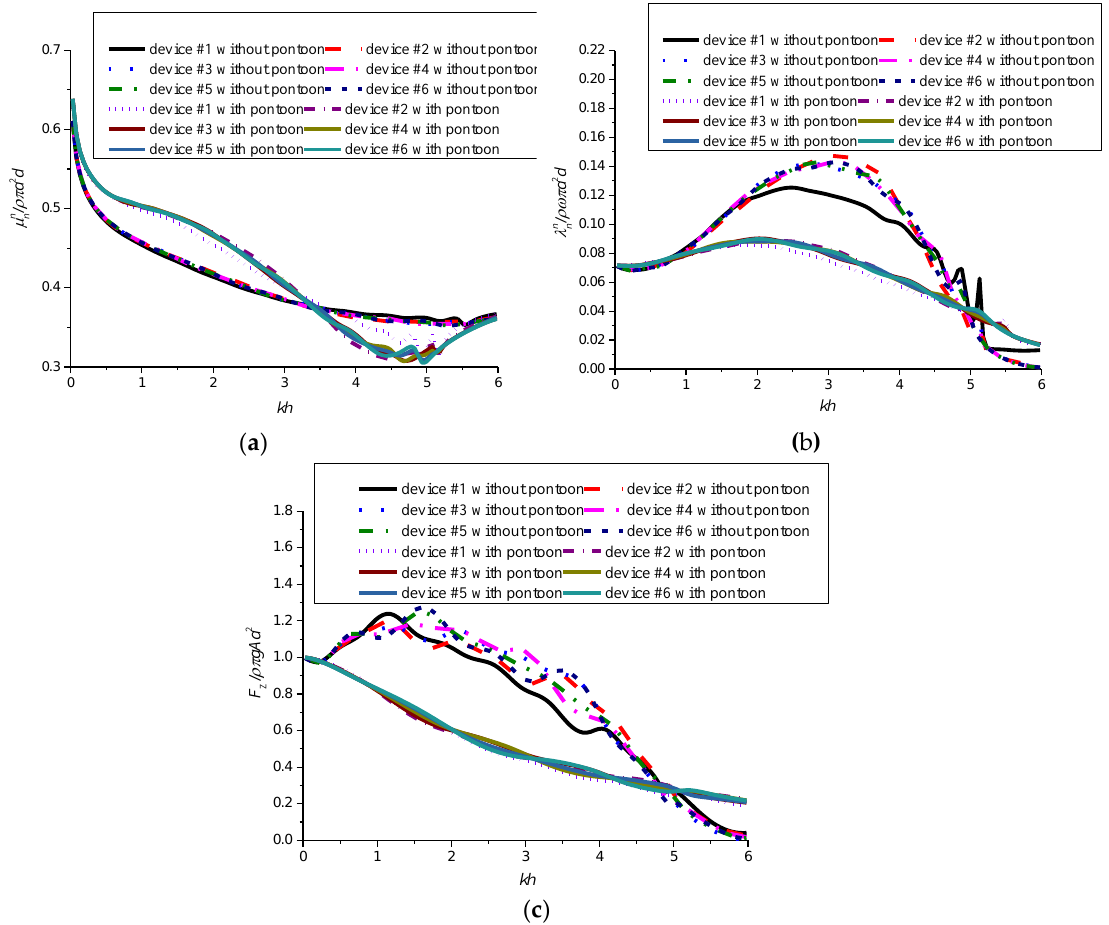
Figure 7. Variations of dimensionless heave added mass ( a ), dimensionless heave damping coefficient ( b ), and dimensionless heave wave exciting force ( c ) of individual WECs with and without the pontoon. ( s 2 / h = 0.2, β = 0°).